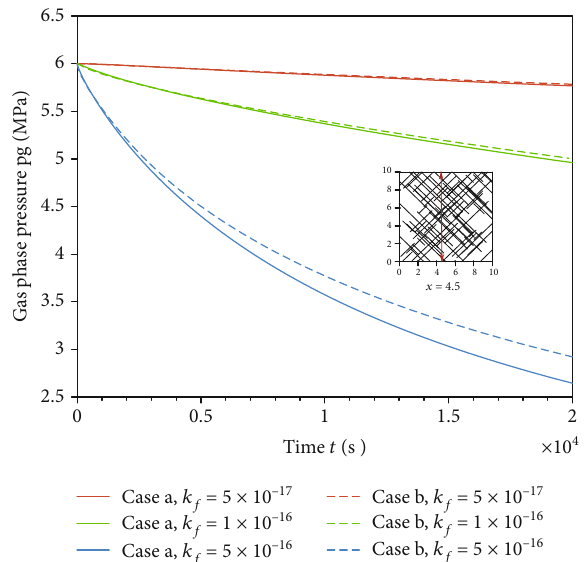
Figure 17: The temporal evolution of average gas pressure along the vertical line x = 0 : 45 with di ff erent fracture permeabilities of k 5 : 0 × 10 − 17 , 1 : 0 × 10 − 16 , and 5 : 0 × 10 − 16 m 2 di ff erent cases with di ff erent fracture permeabilities of 5 : 0 × 10 − 17 , 1 : 0 × 10 − 16 , and 5 : 0 × 10 − 16 m 2 . The pressure